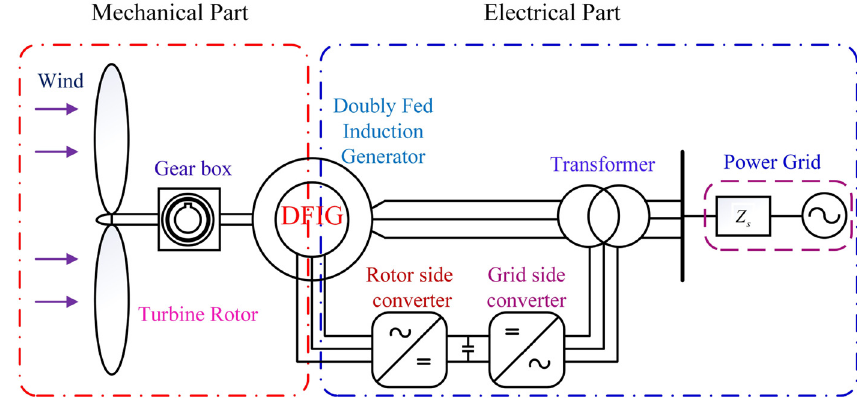
Figure 1: Basic layout of the WT generator with DFIG.